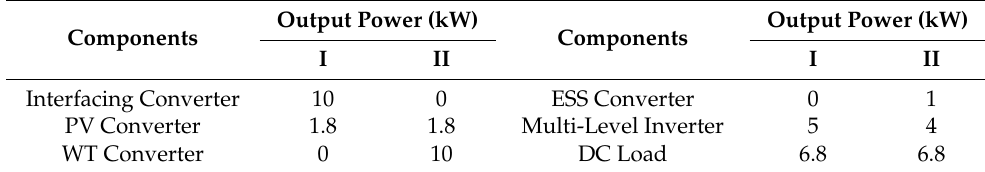
Table 7. Output power of each power conversion devices in mode 7.